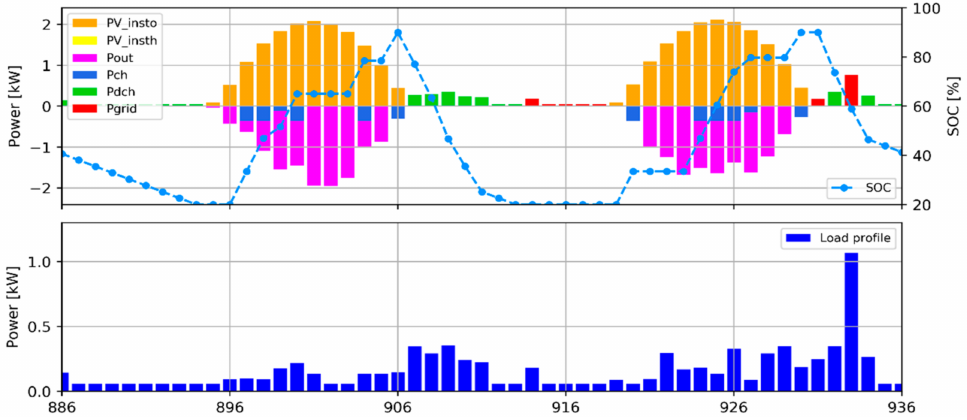
Figure 9. Operation graph of a household’s microgrid for an 8 h fault (start time: 906 h, Case